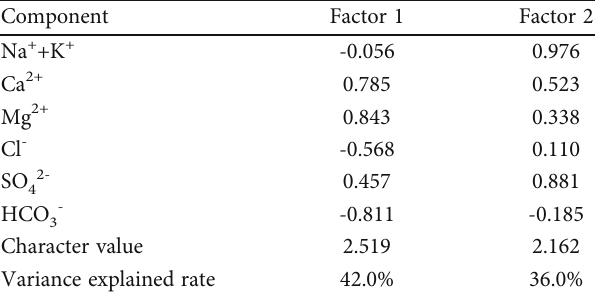
Table 6: Result of factor analysis.